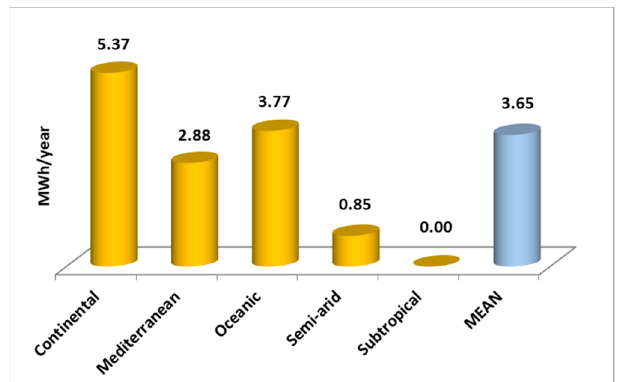
Figure 9. Mean energy consumption per inhabitant by climate zone.